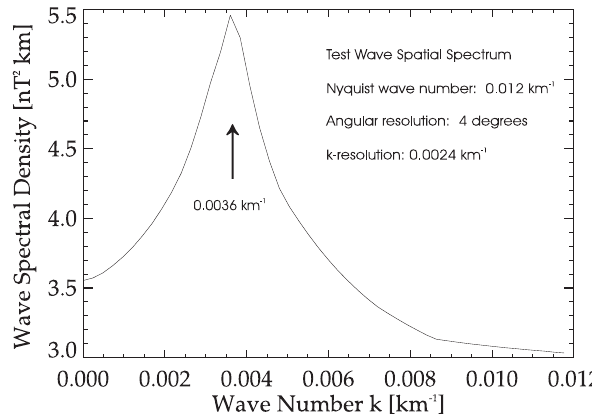
Fig. 1. Spatial spectral density distribution resulting from applying the wave telescope to the artificial data set.